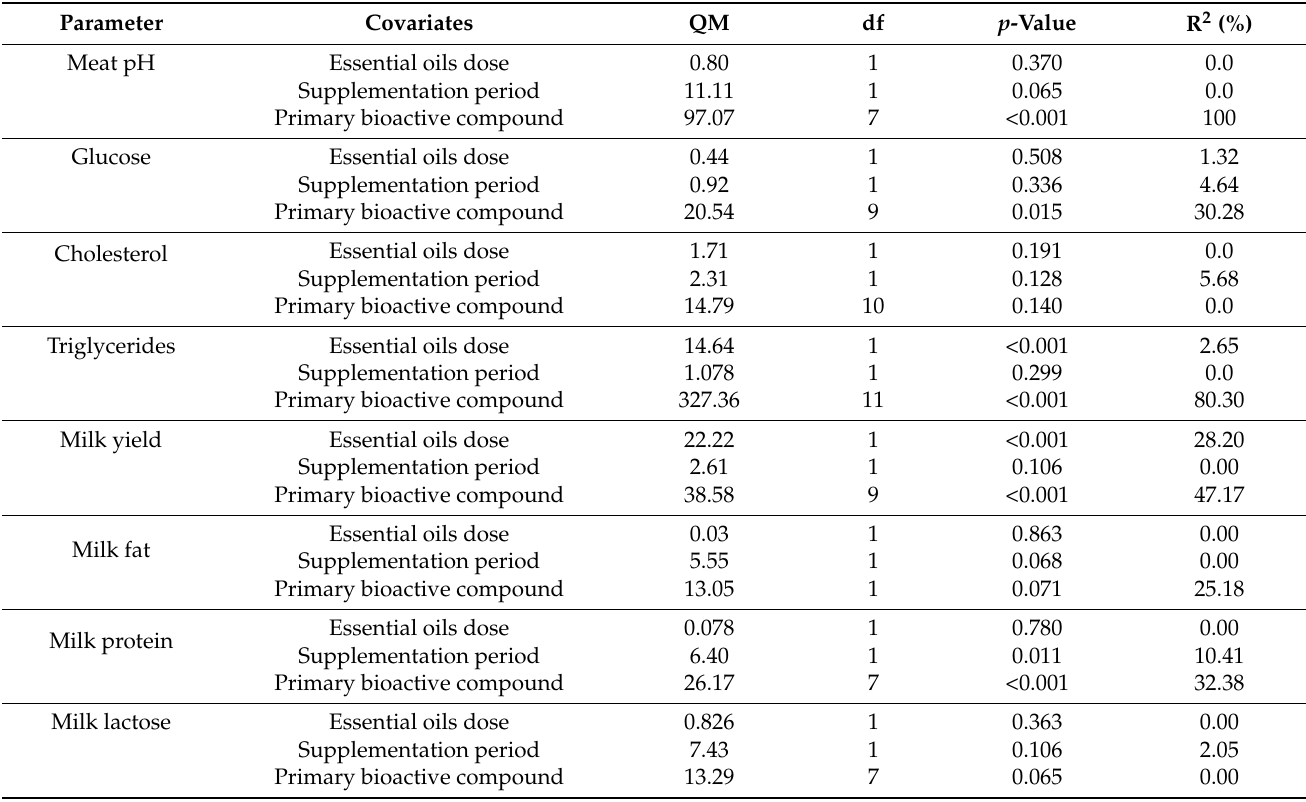
Table A2. Meta-regression comparing the associations between covariates and measured